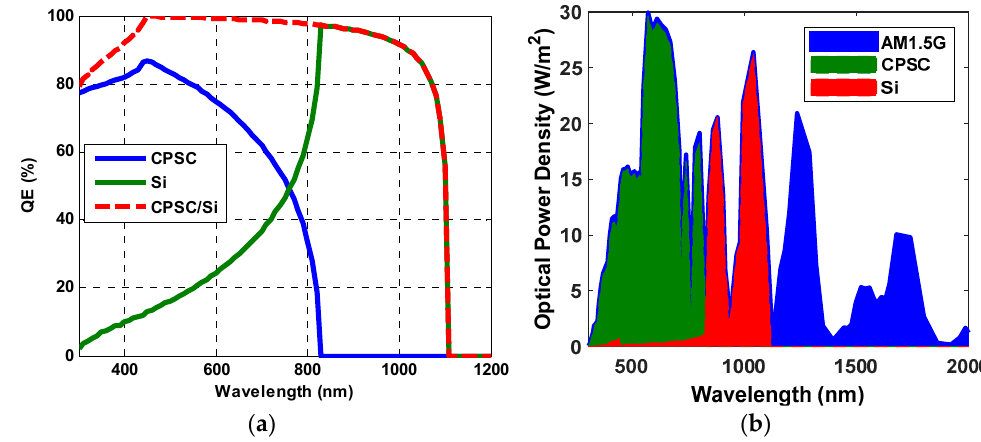
Figure 7. ( a ) EQE curves of CPSC/Si sub-cells and tandem solar cell, and ( b ) the absorbed spectrum of AM1.5G by the CPSC/Si tandem solar cell.